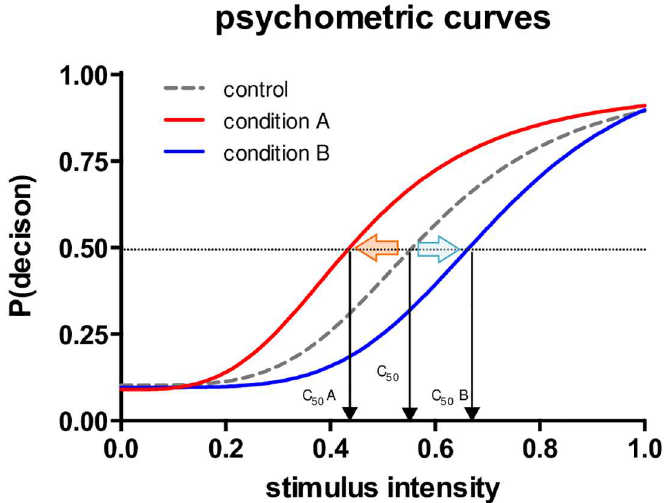
Fig 3. Psychometric response curve modeling by Naka-Rushton contrast response function. X-axis represents stimulus intensity level and Y-axis representsresponse probability. The stimulus intensity in this study represents the incremental increaseof emotionalintensity of facial expressions. The response represents the proportionof happy(experiment1) or sad (experiment2) decisionsin a two-alternative forced choice task. The C 50 or PSE (Point of Subjective Equality) parameter indicatesthe perceptualdecision threshold. A leftward shift of the psychometric curve (red arrow) would constitute evidencefor a decreased perceptual thresholdfor conditionA compared to the control condition, and a rightwardshift of the psychometric curve (blue arrow) would constitute evidencefor an increasedperceptual thresholdfor condition B comparedto control condition, respectively.